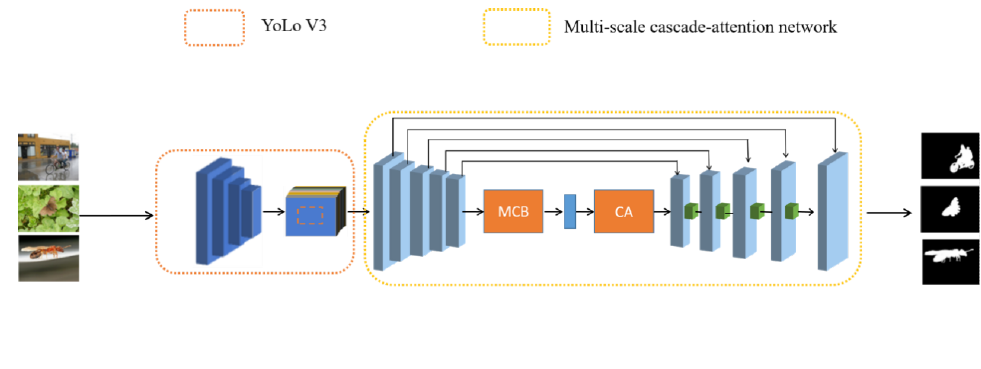
Figure 1. Overall architecture of the proposed network.